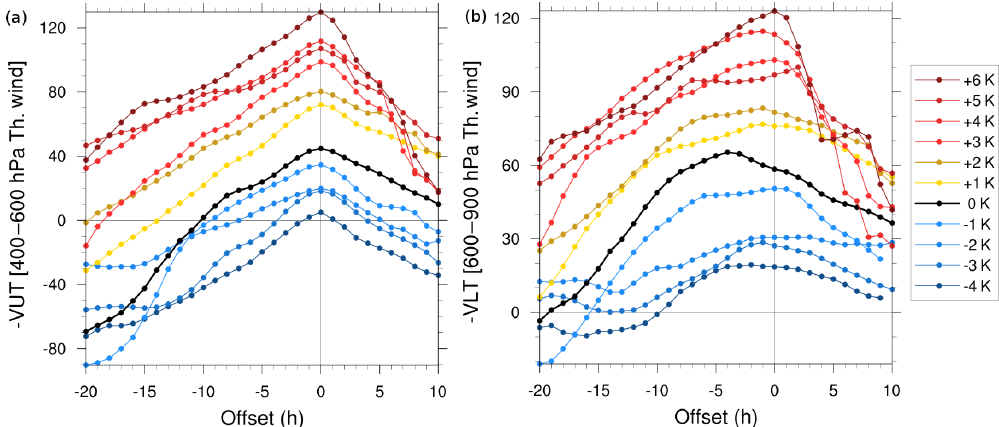
Figure 9. Composite time series of (a) − V U